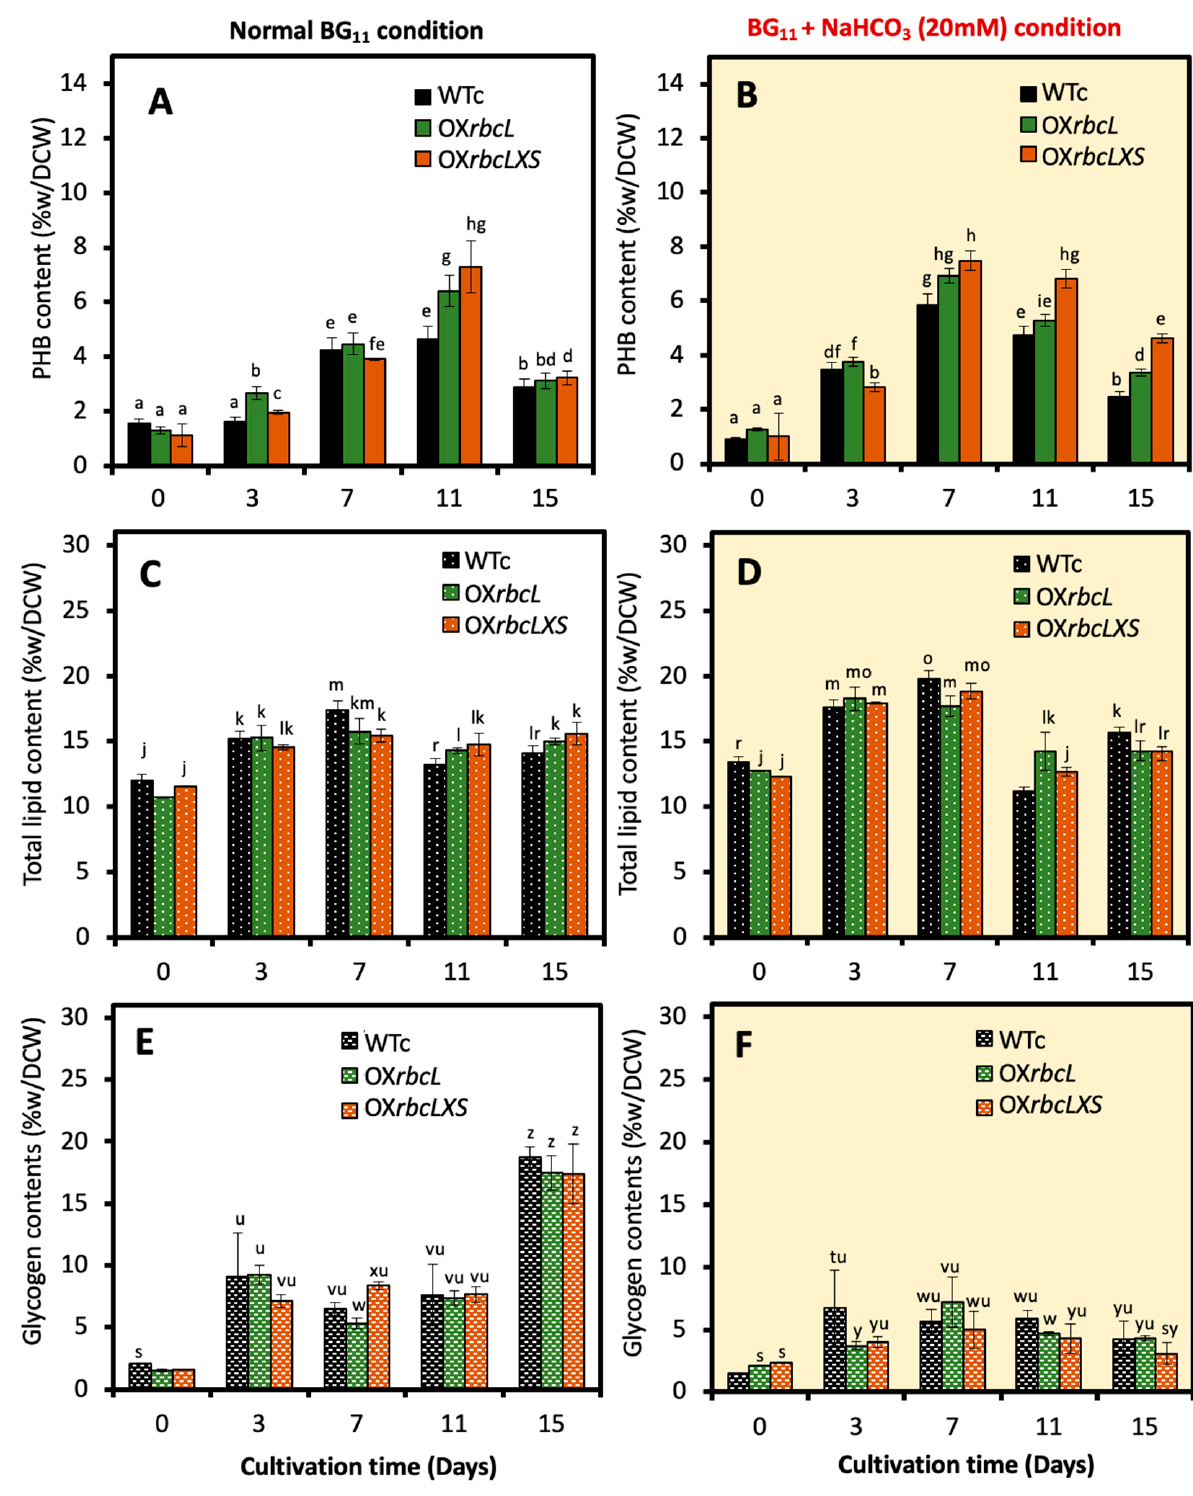
Figure 4. PHB contents ( A , B ), total lipid contents ( C , D ), and glycogen contents ( E , F ) of Synechocystis WTc, OX rbcL , and OX rbcLXS strains grown in normal BG 11 medium and BG 11 medium containing 20 mM NaHCO 3 (BG 11 + NaHCO 3 condition), respectively, for 15 days. The error bars represent standard deviations of means (means ± S.D., n = 3). Means with the same letter are not significantly different with the significance level at p < 0.05.